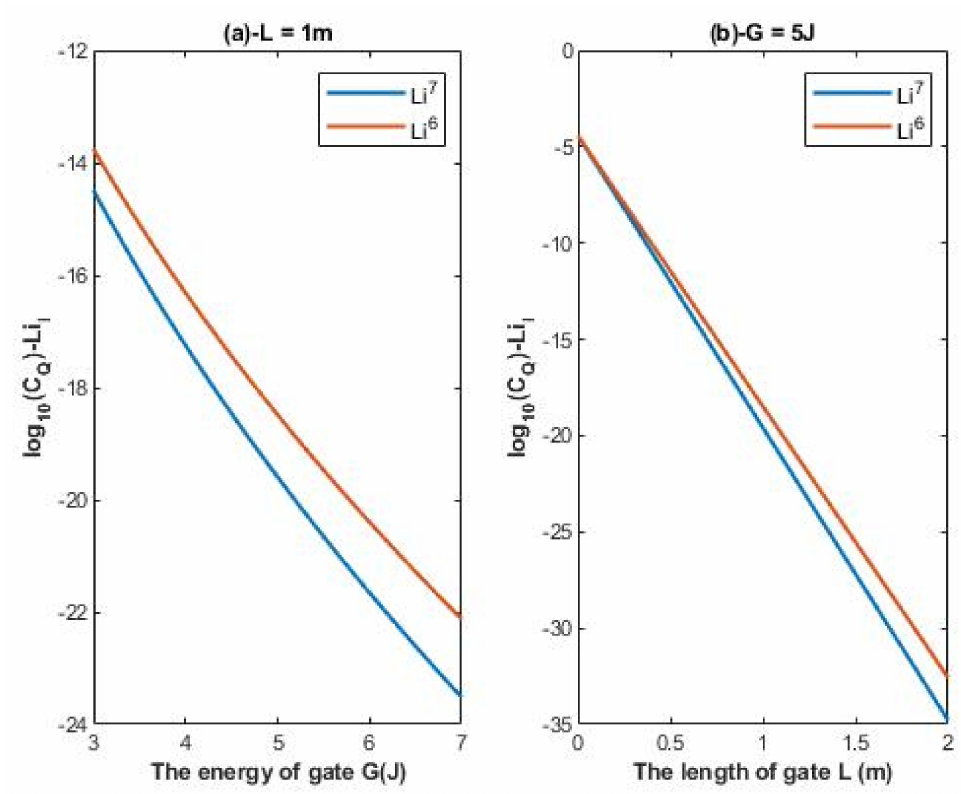
Figure 5. ( a ): The figure represents the relationship between the common logarithm of quantum conductance of single channel for the intracellular lithium isotopes log of gate G by setting L = 1 m and across the range of G from 3 J to 7 J. ( b ): The figure represents the relationship between the common logarithm of quantum conductance of single channel for the intracellular lithium isotopes log across the range of L from 0 m to 2